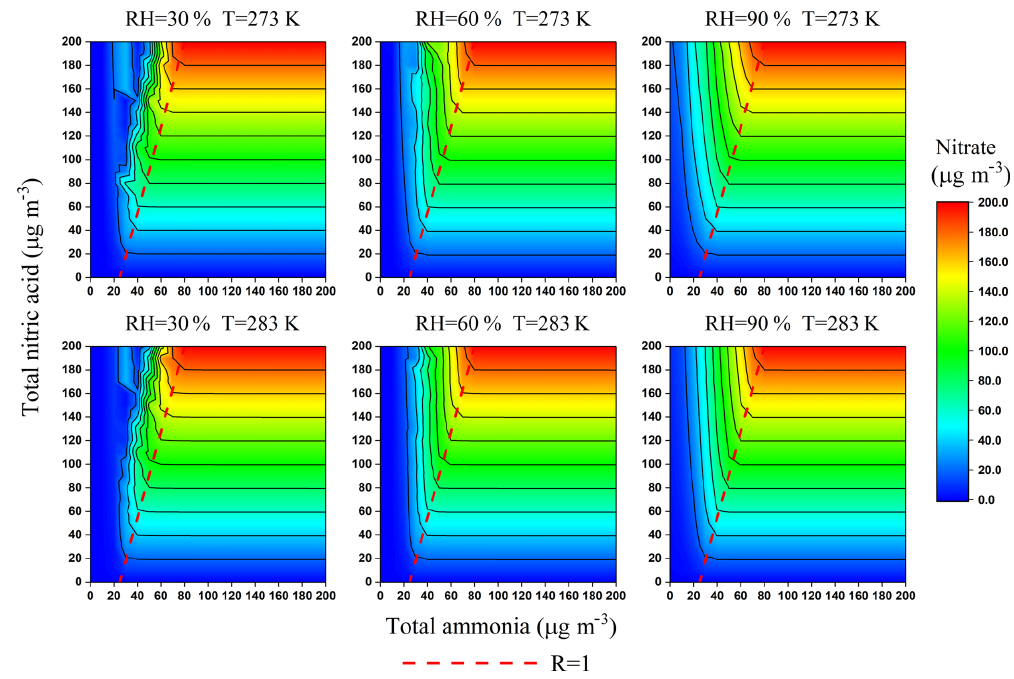
Figure 3. Isopleths of the particulate-NO − concentration (µgm − 3 ) as a function of TN and TA under average severe haze conditions in 3 winter. The concentration of SO 2 − , Cl − , K + , Ca 2 + , Na + and Mg 2 + was 60.2, 9.3, 0.56, 0.04, 0.75 and 0.03µgm − 3 , respectively. Values 4 are averages from all severe hazes during the observation period.